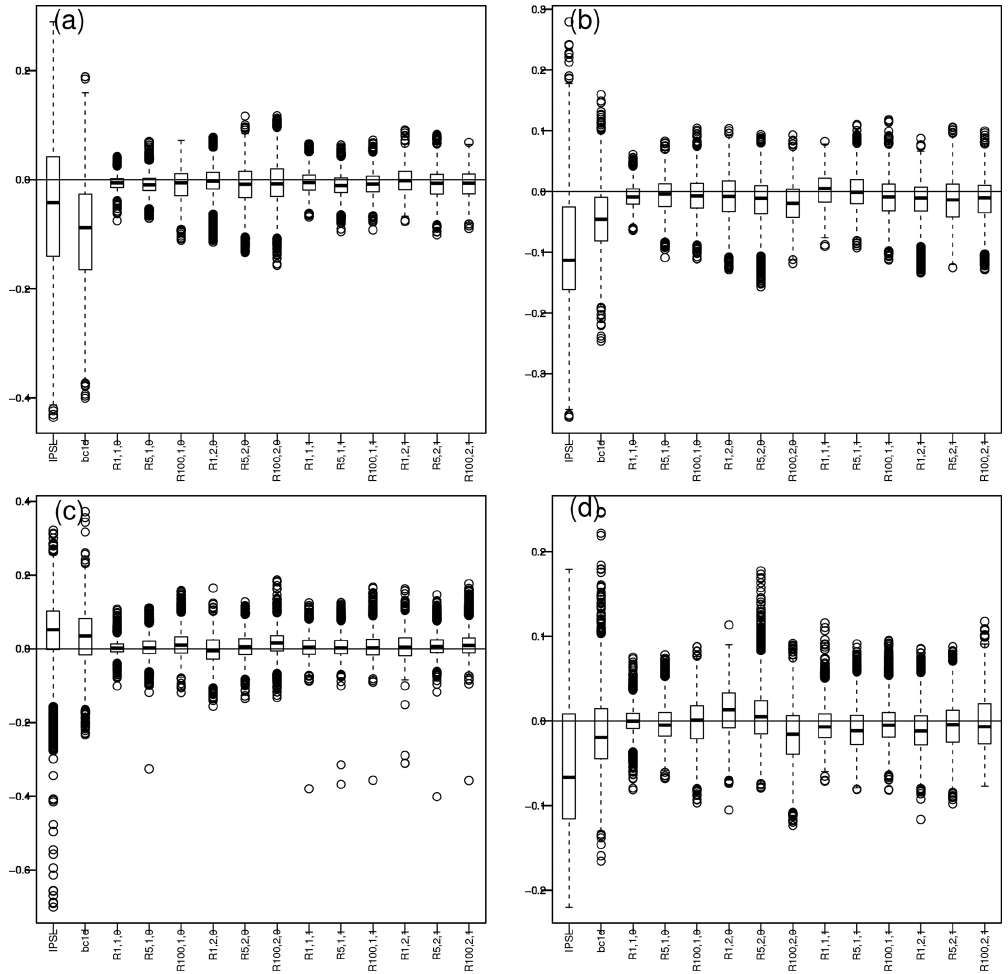
Figure 8. Boxplots of differences in temperature vs. precipitation Pearson correlations between WFDEI and the different datasets (IPSL, 1d-BC IPSL and the R 2 D 2 configurations) over 1979–2016 in (a) winter, (b) spring, (c) summer and (d) fall. The associated maps are given for each season in the